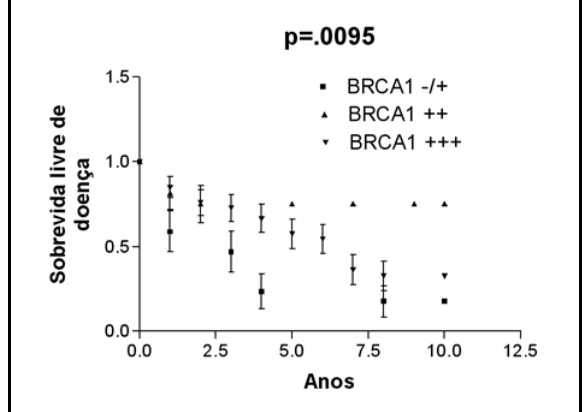
Figura 3 – Taxa de sobrevida livre de doença em relação à porcetagem de expressão do BRCA1